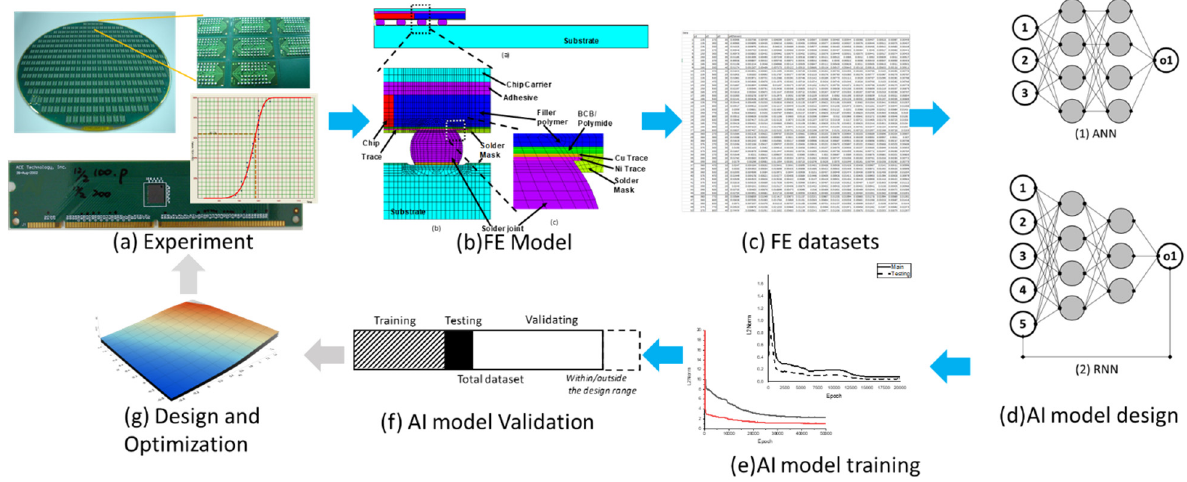
Figure 3. The AI-assisted simulation framework [3,14] ( a ) Experiment; ( b ) FE model; ( c ) FE datasets; ( d ) AI model design; ( e ) AI model training ( f ) AI model validation; ( g ) Design and optimization.